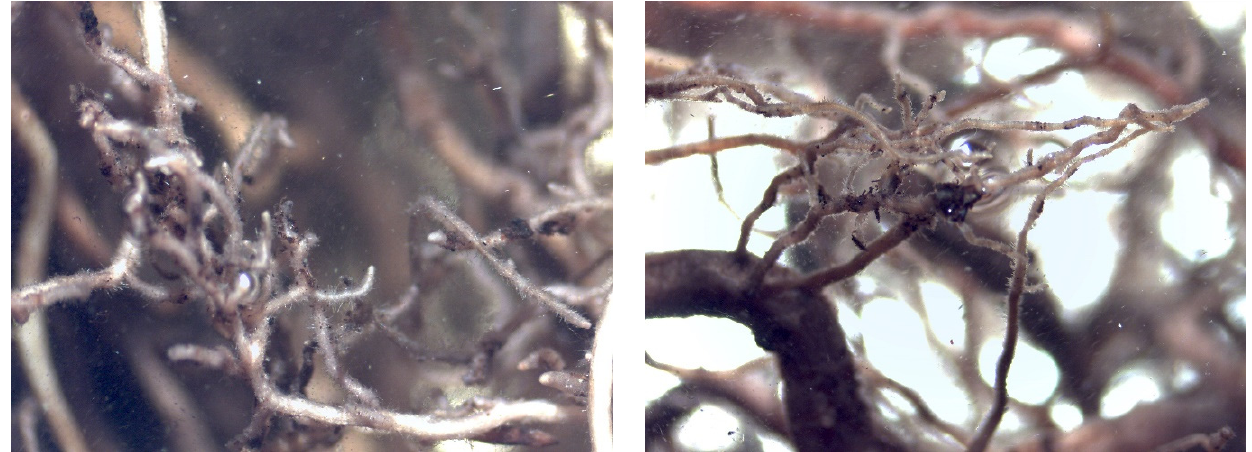
Figure 4. Detail of roots of Nothofagus alessandrii seedlings inoculated with Hebeloma crustuliniforme ( left ) and Thelephora terrestris ( right ).